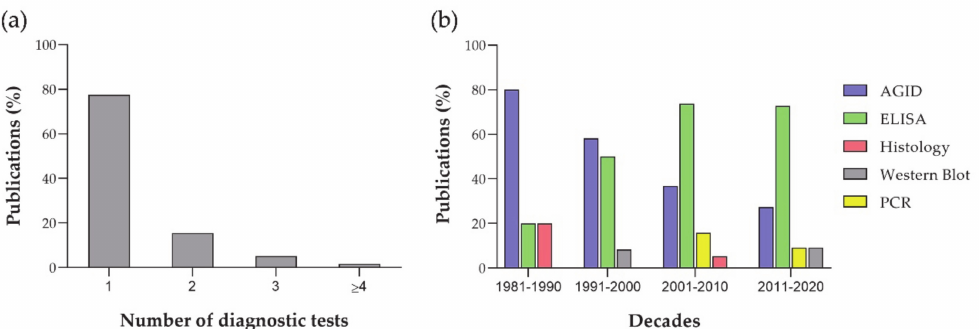
Figure 1. Analysis of diagnostic tests: ( a ) number of diagnostic tests performed in each article; and ( b ) evolution of the diag- nostic tests from 1981 to 2020.